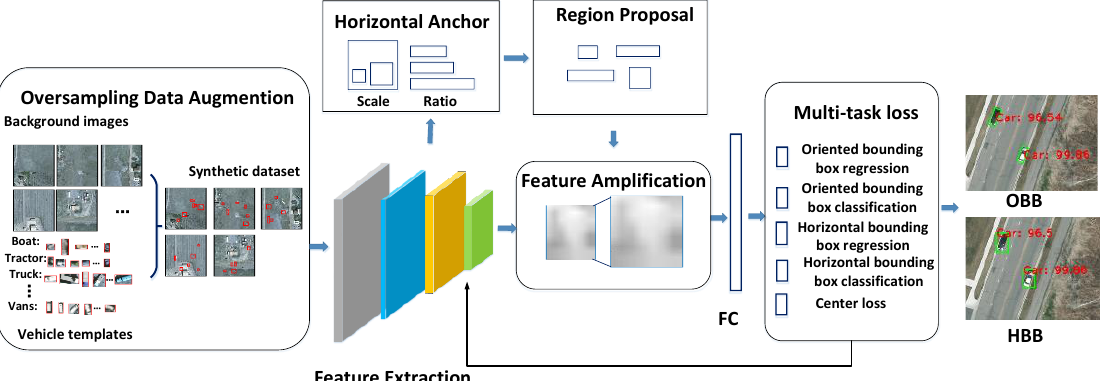
Figure 3. The flowchart of oriented vehicle detection based on feature amplification and oversampling data augmentation in aerial images.